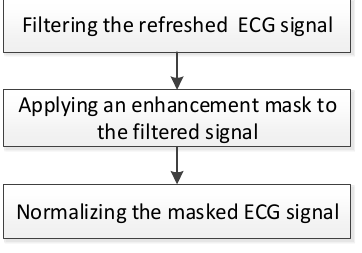
Figure 5. Signal transform procedure.